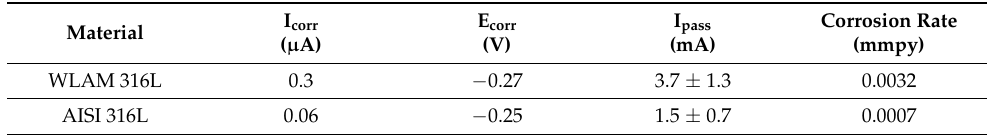
Table 4. Corrosion characteristics of the WLAM sample and its counterpart AISI 316L alloy, along with corrosion rate measurements obtained by Tafel